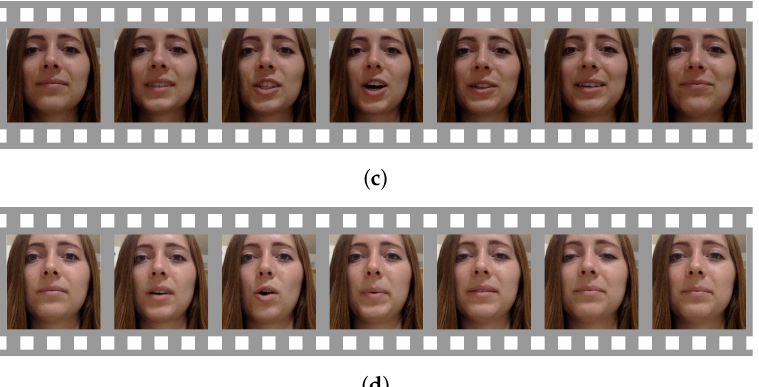
Figure 4. Examples of our facial motion analysis dataset. ( a , b ) are customized facial motions while ( c , d ) are lip